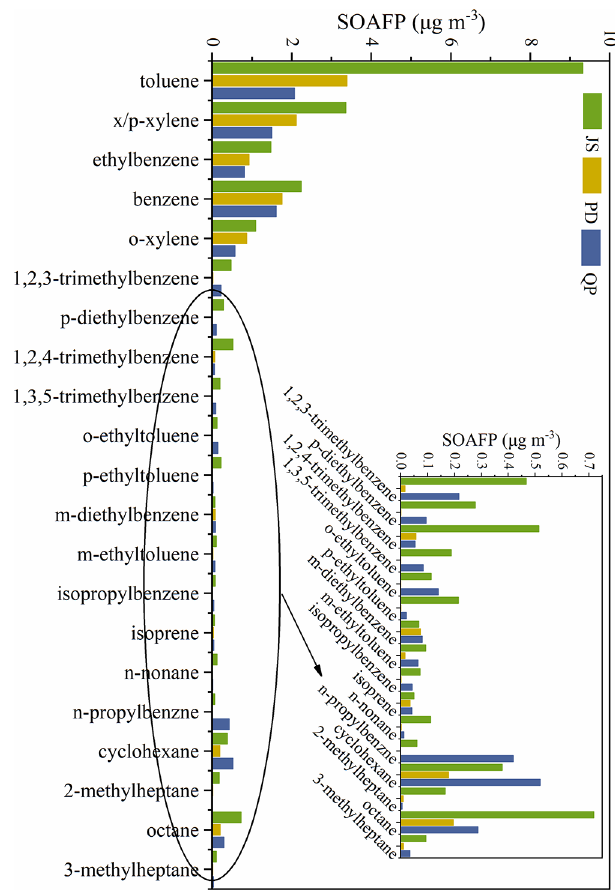
Figure 9. The SOAFP analysis of different VOC species at the JS, PD and QP